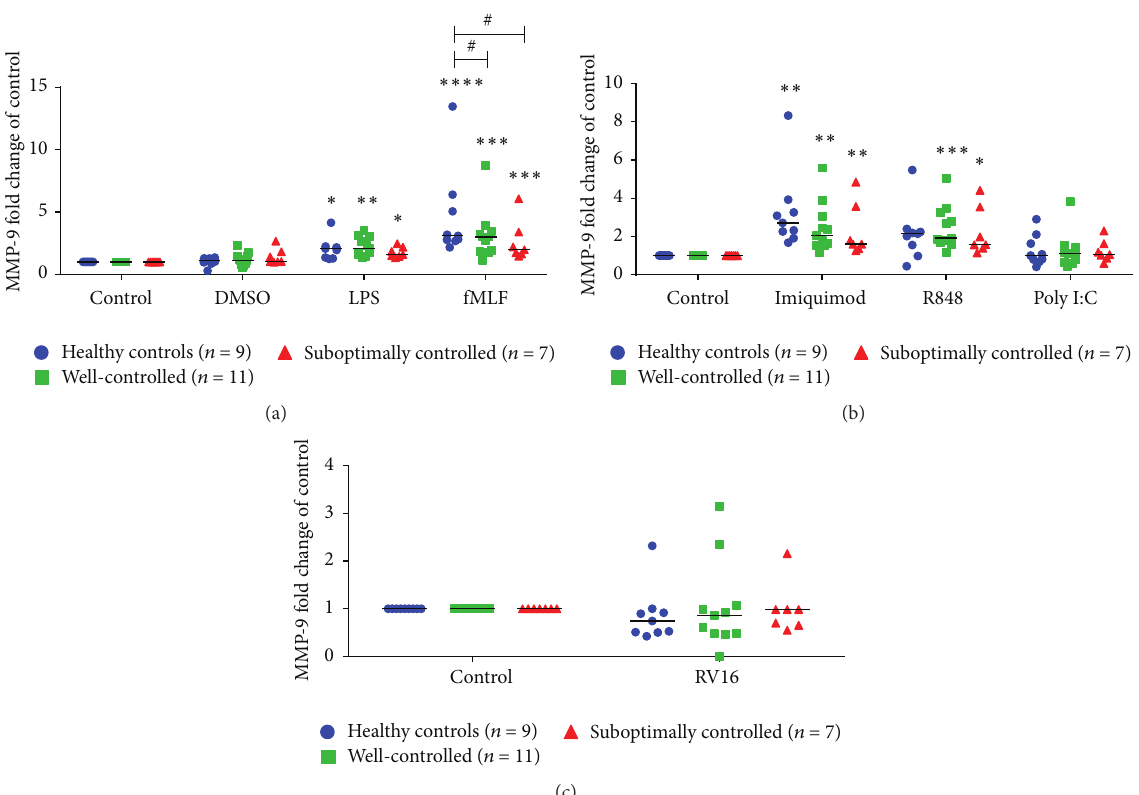
cytokine production due to the cumulative effect of a greater number of neutrophils present. Dysregulation in